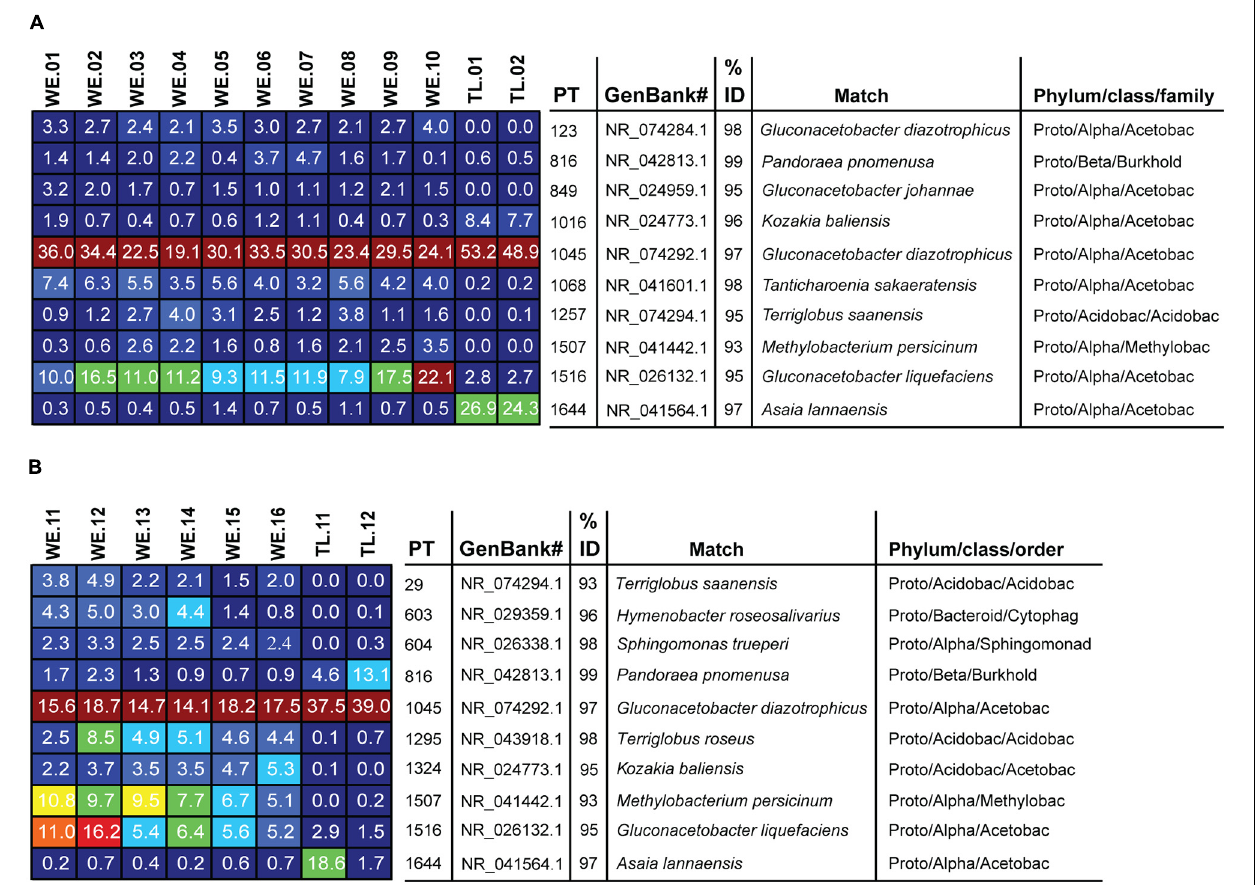
FIGURE 4 | Heatmap showing the 10 most dominant phylotypes and their average relative abundances as percentages of all sample 16S rRNA gene sequences recovered in our conifer needles samples. (A) P. flexilis , (B) P. engelmannii . Color tones range from cool (blue) to warm (red) to indicate the lowest to highest relative abundance values. Phylotypes were considered dominant if they were both highly abundant